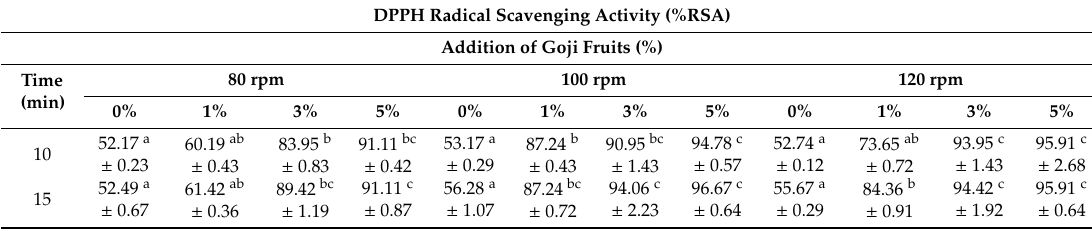
Table 2. DPPH radical scavenging activity of instant corn gruels enriched with goji fruits depending on time, screw speed and goji fruits addition (n = 3 mean ± SD). DPPH Radical Scavenging Activity